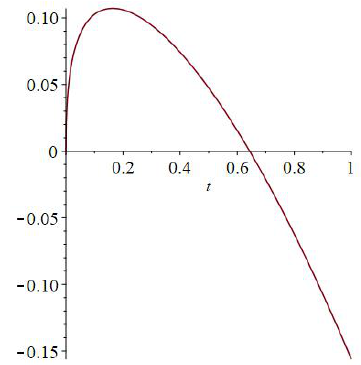
Figure 1. Graph of function h from Remark 1 for the values b = 0.1, α = 0.1, β = 0.5, λ = 1, τ α q = = 0.3, τ β T